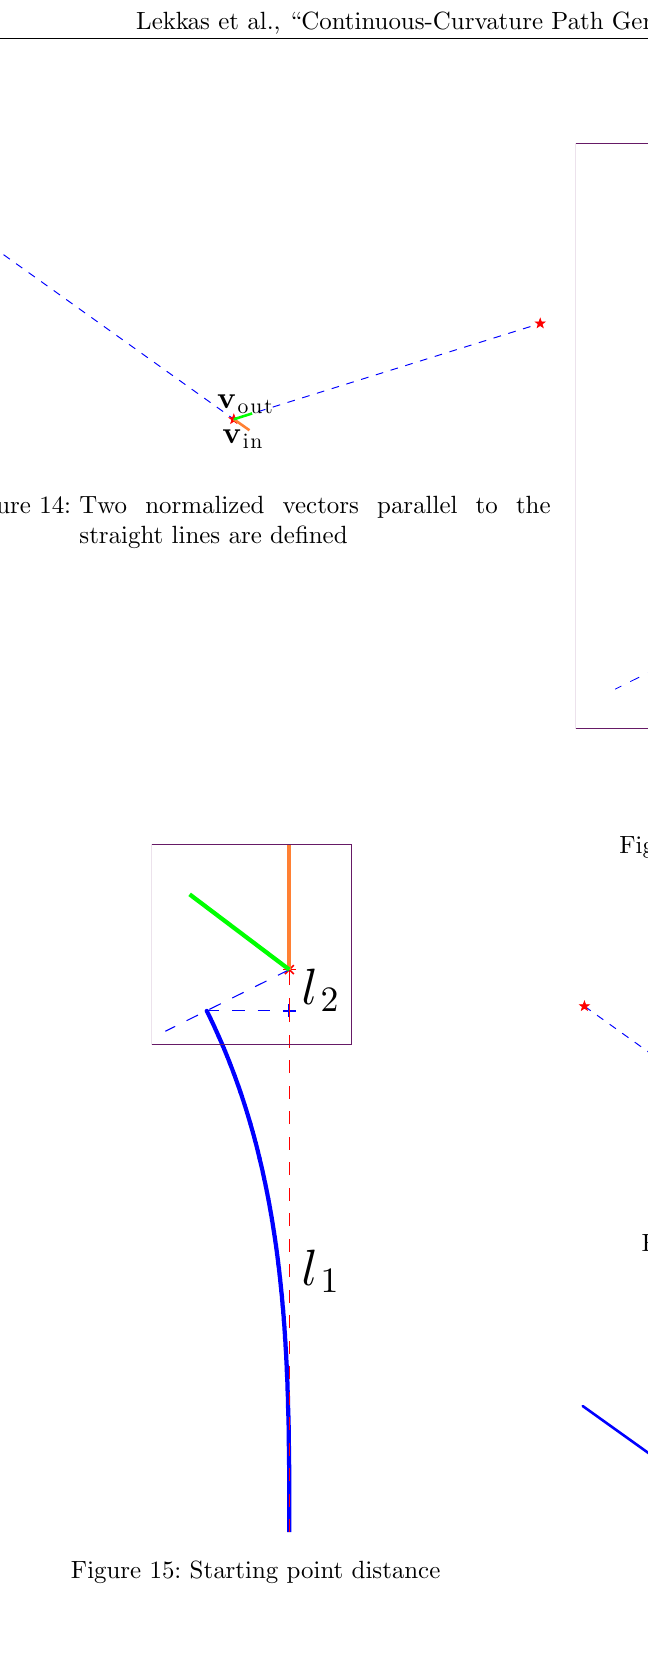
Figure 18: Final path